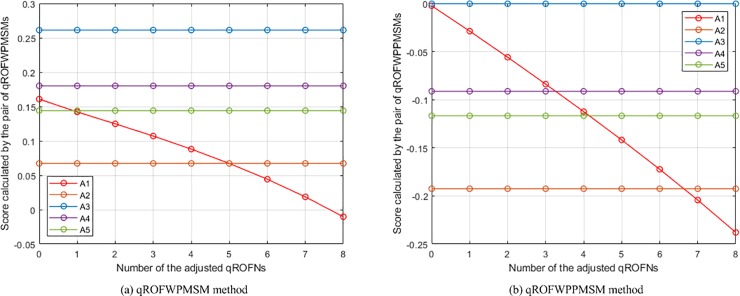
The changes of the places of A1 in the rankings of the WPMSM and WPPMSM methods.